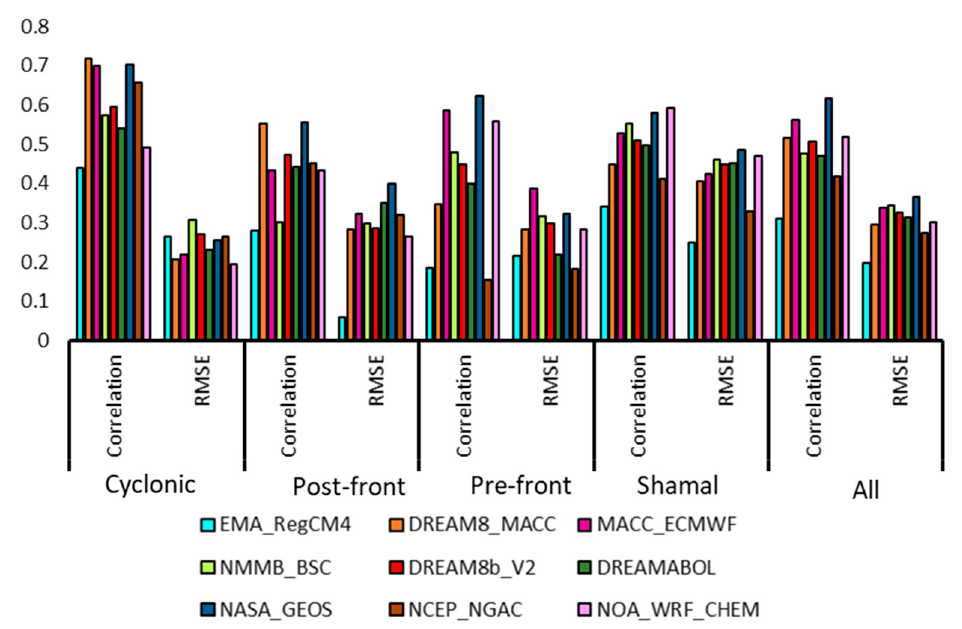
Figure 12. Pearson correlation coefficient and RMSE values of the performance of various models during dust storms of different types in the Middle East. Table 3. Statistical results ( R 2 ) from the evaluation of the forecasted AODs of each model against AODs at 3 AERONET